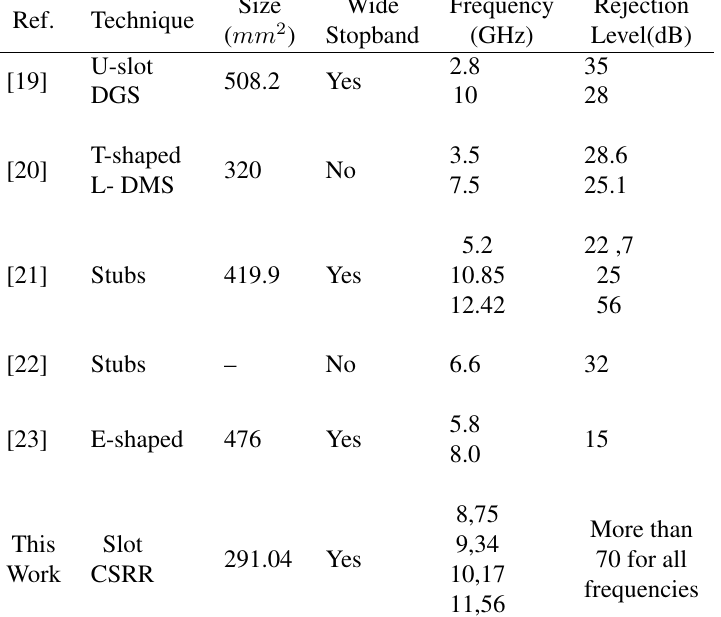
Table 3: Comparison of the proposed filter and similars published in literature